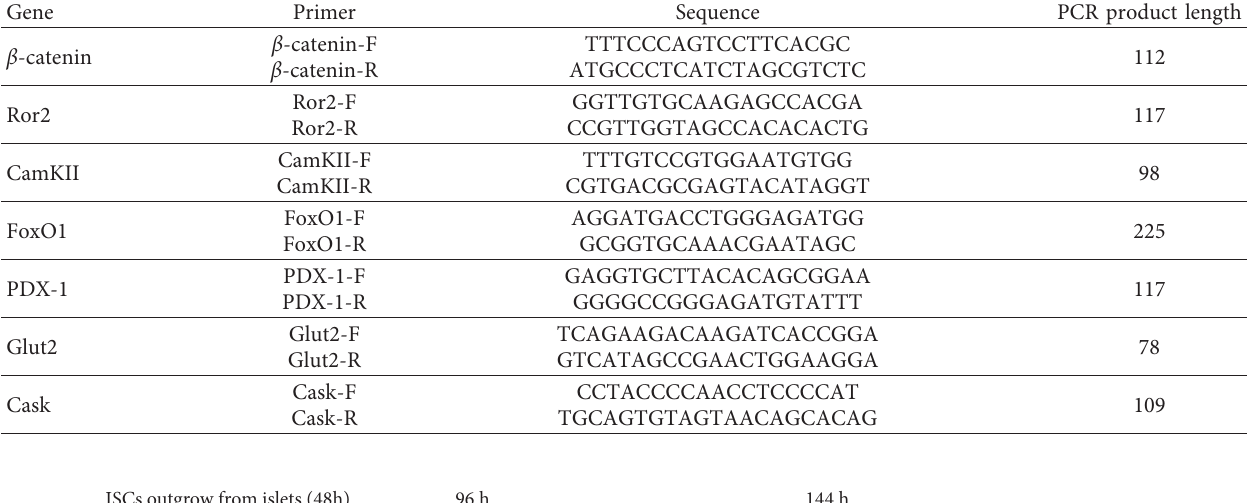
Table 1: The PCR primer